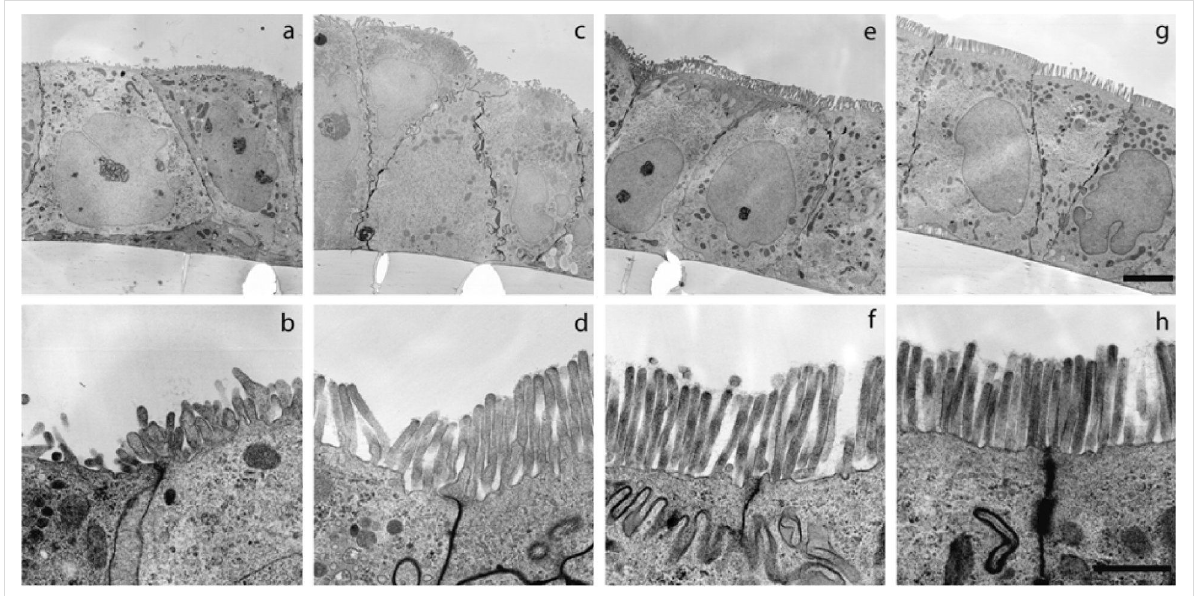
Figure 1: Differentiation of Caco-2 cells over 21 days post-confluence. a,b: With reaching confluence, cells have built a monolayer and rudimentary microvilli are visible; c,d: 7 days after formation of a confluent monolayer microvilli are pronounced; e,f: 14 days post-confluence cells are grown to a columnar epithelium, the microvilli have increased, tight junctions are formed and the glycocalyx between and on the top of the microvilli is visible; g,h: 21 days post-confluence all structural attributes of intestinal epithelial cells are formed. Upper panel (a,c,e,g): Scale bar, 5 µm, lower panel (b,d,f,h): Scale bar, 1